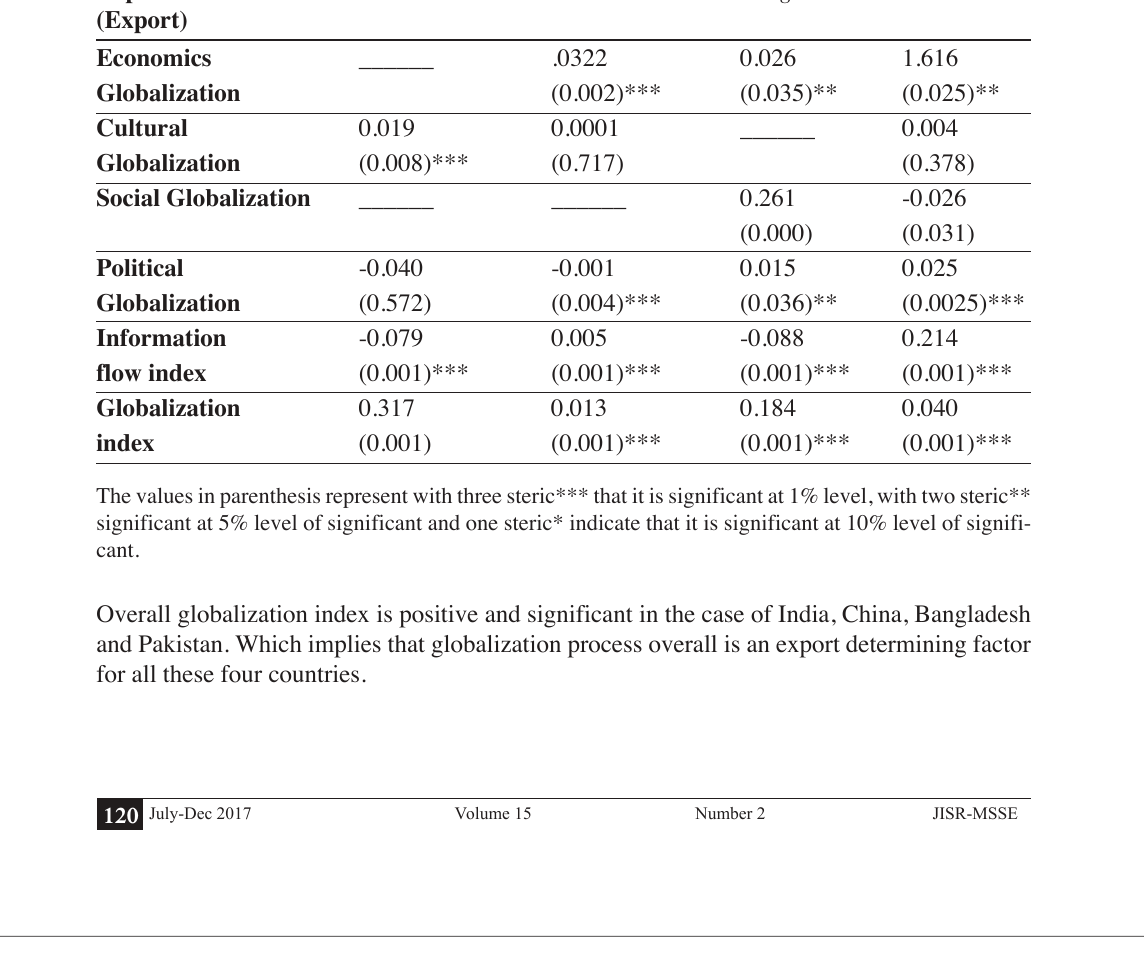
TABLE-4 Four models to capture the impact of globalization using PPML